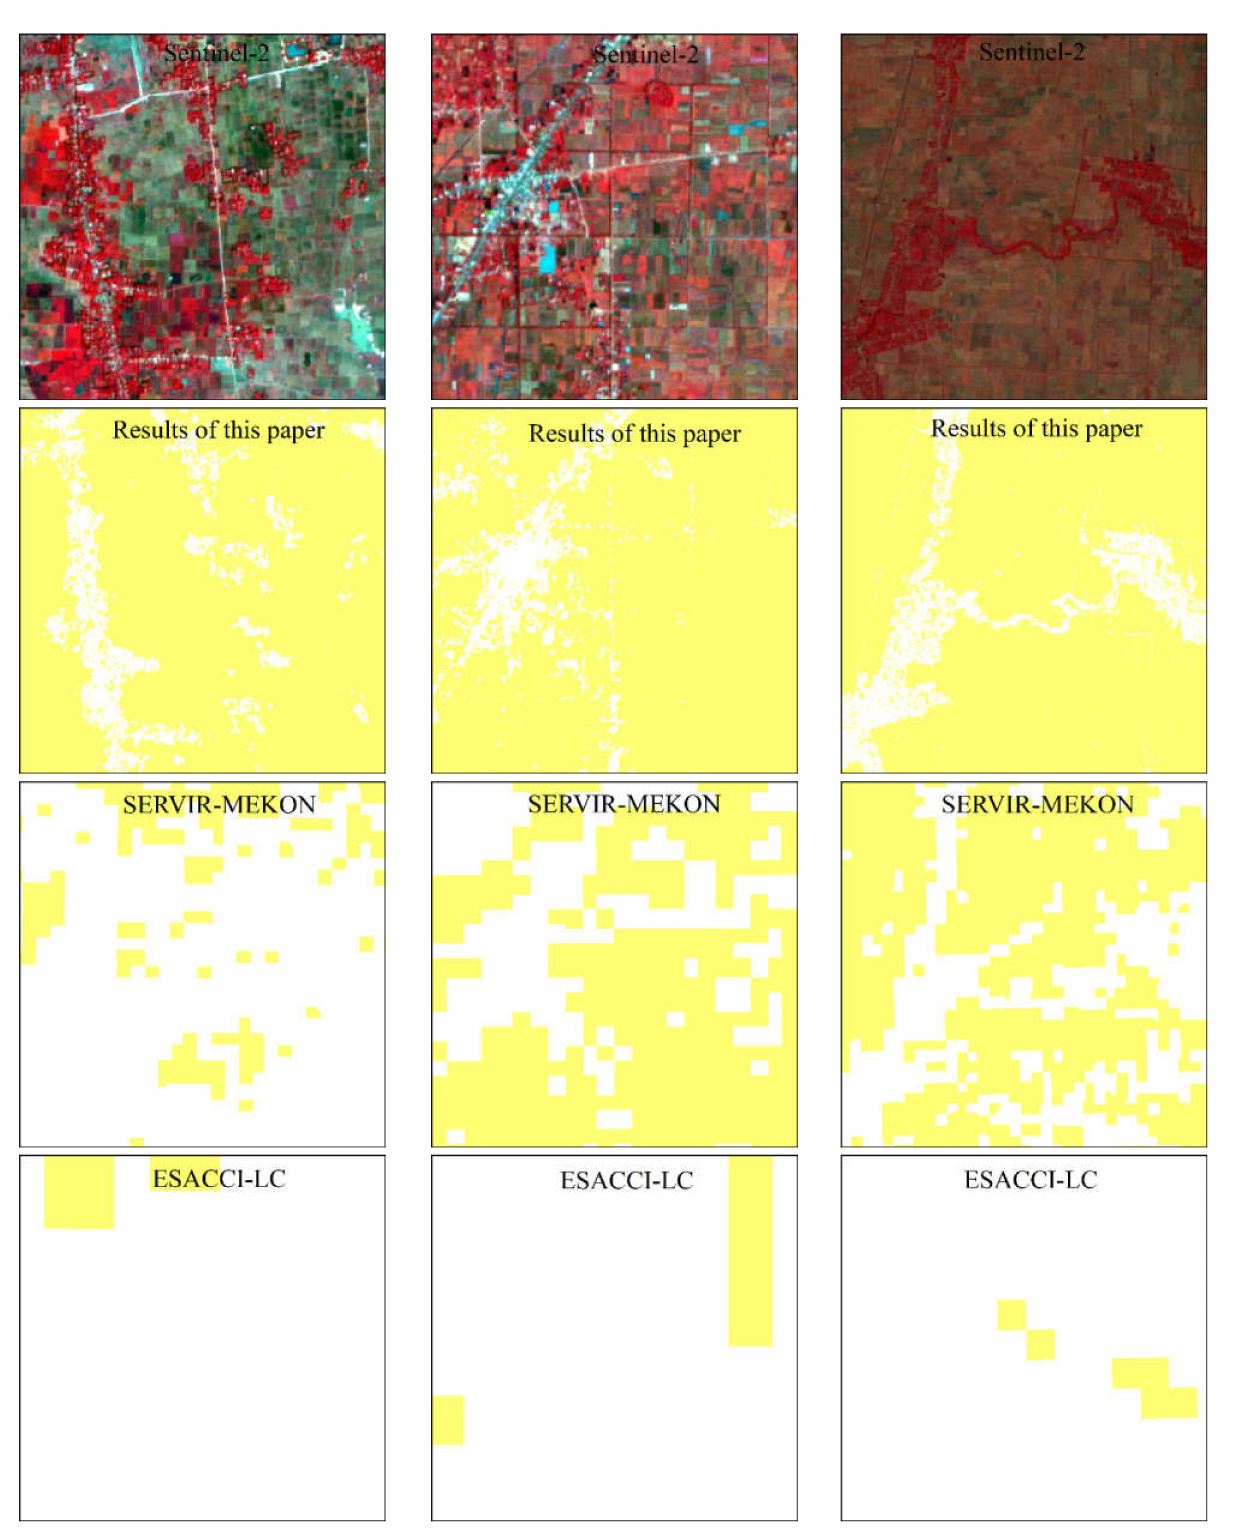
Figure 13. Comparison of the paddy extraction results of each product with Sentinel-2 images (R: B8; G: B4; and B: B3). The yellow area represents paddy, and the white area represents